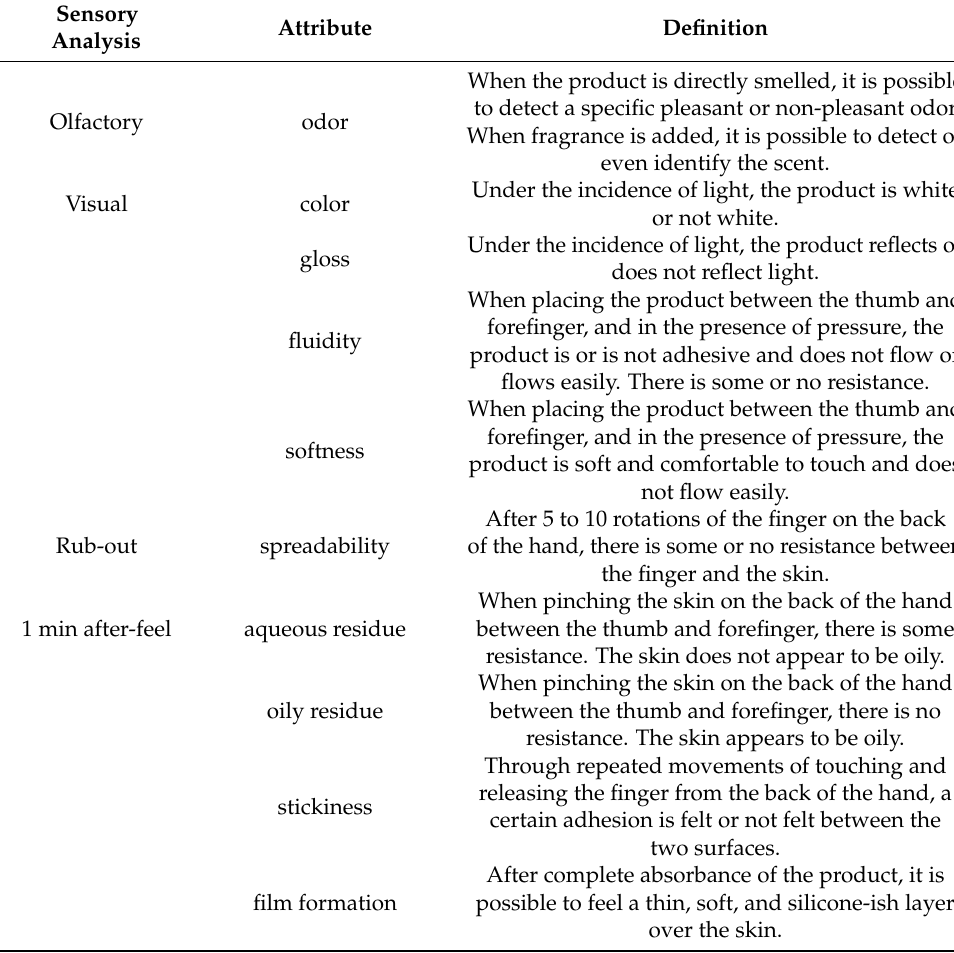
Table 2. Definitions of the sensory attributes evaluated by the